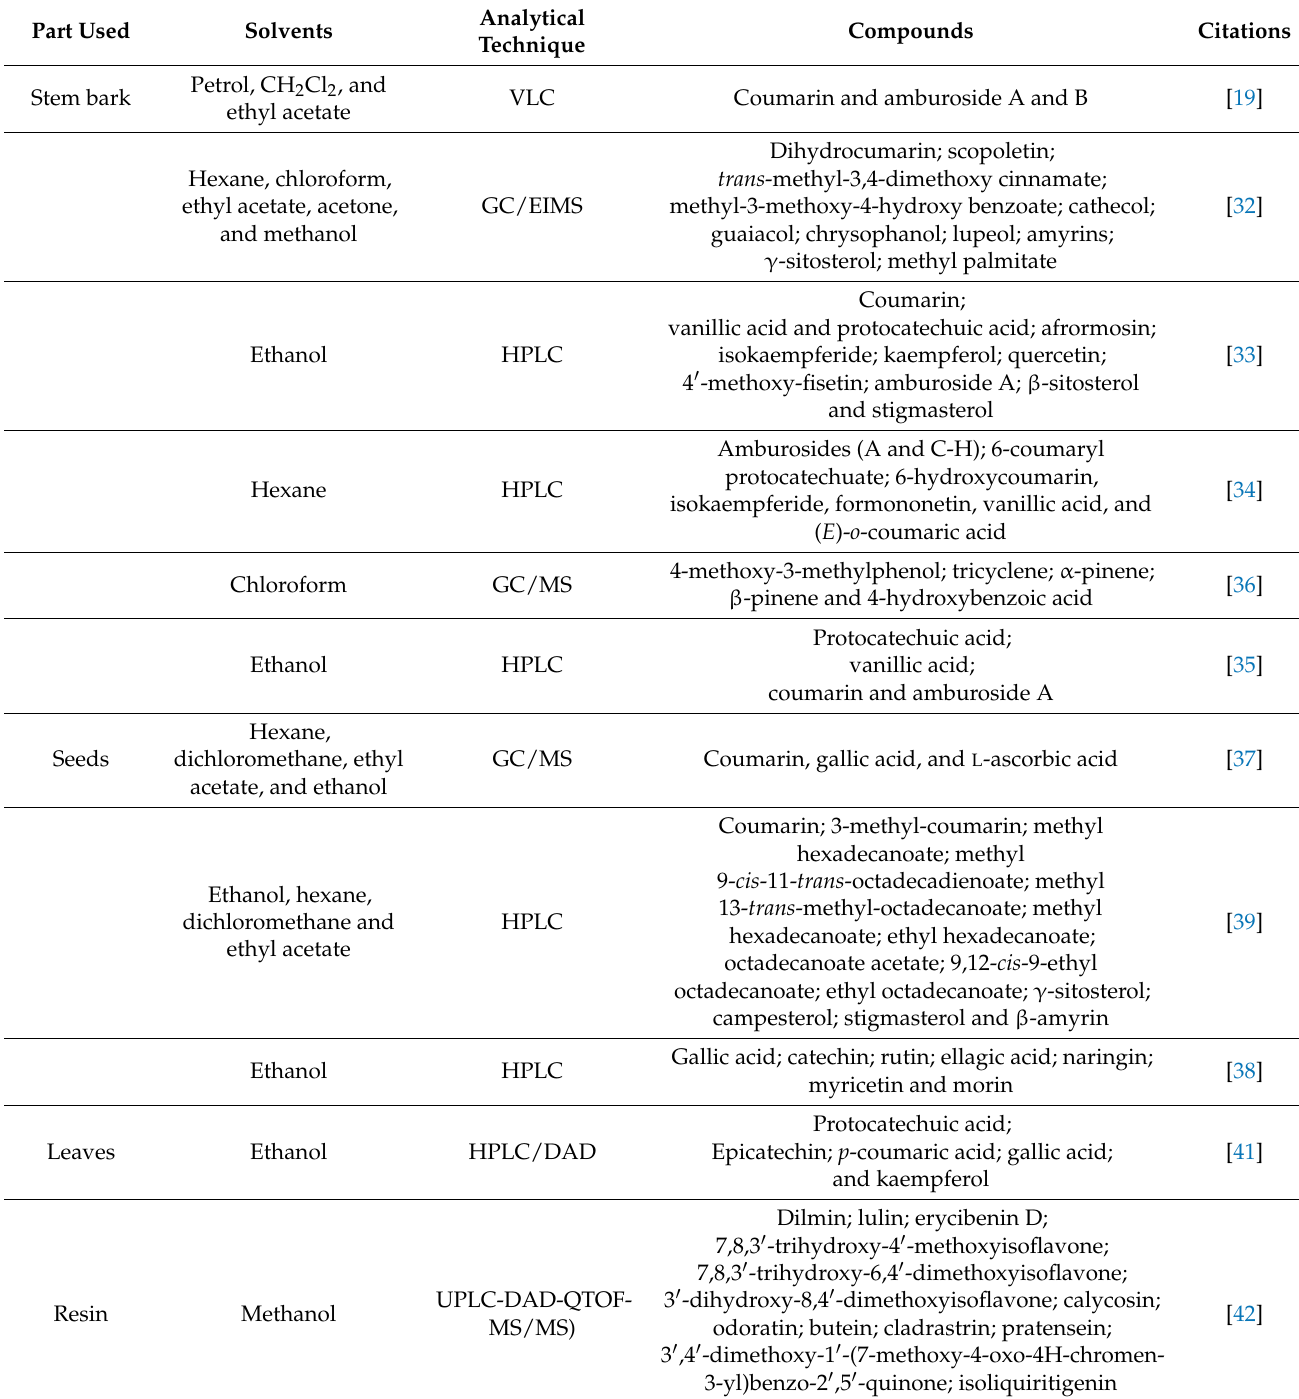
Table 1. Chemical compounds identified in A. Cearensis by differents analytical